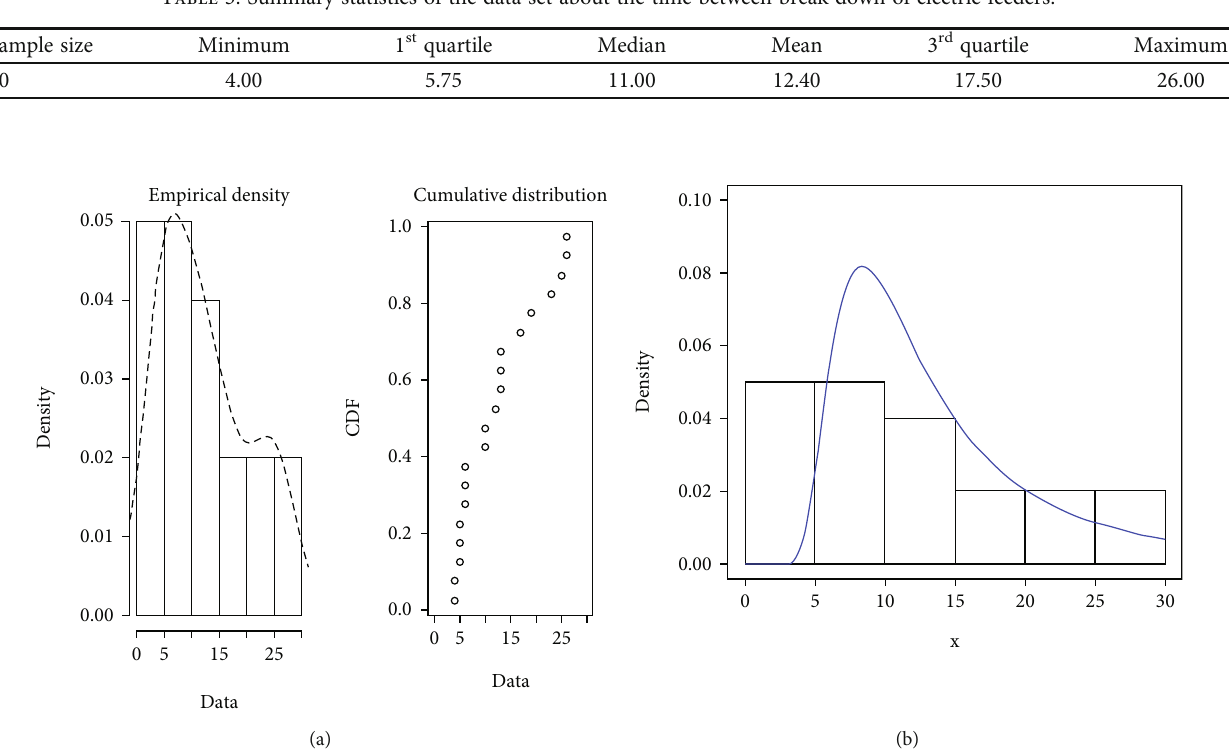
Figure 3: (a) Empirical and cumulative distribution of the data. (b) Goodness of fi t curve of the IRE distribution to the